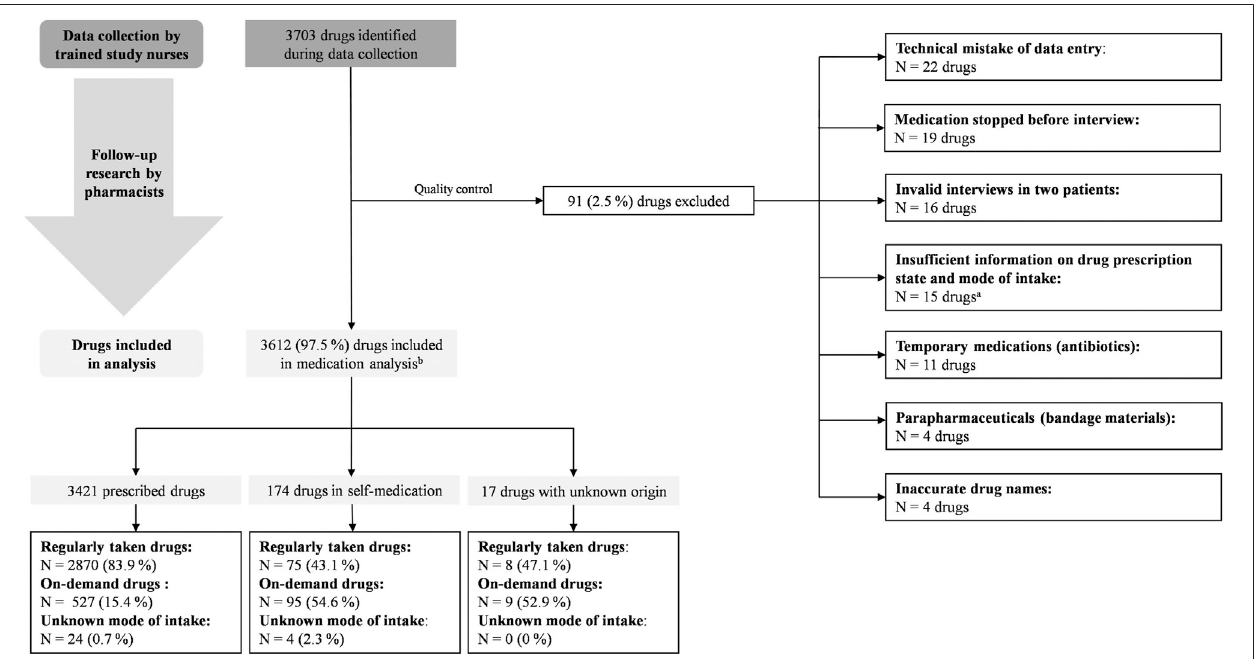
FIGURE 1 | Flow-diagram showing medication screening and selection process. a All drugs were non-prescription drugs. b Different patients may use the same drug.